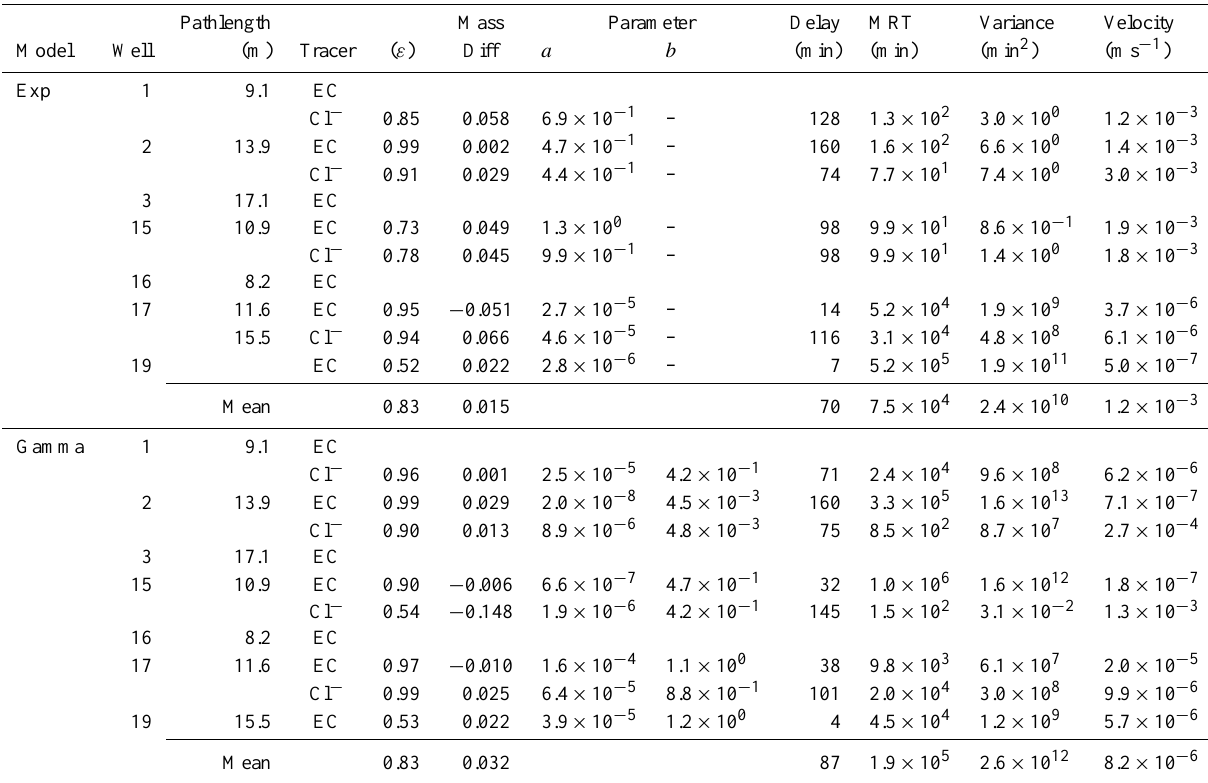
Table 5. Modeling results of tracer transport for salt-added test. Negative values of Mass Diff (proportional mass difference) indicate greater mass in the model than in the observations. Individual well–tracer combinations that were not modeled are included in the table as blank